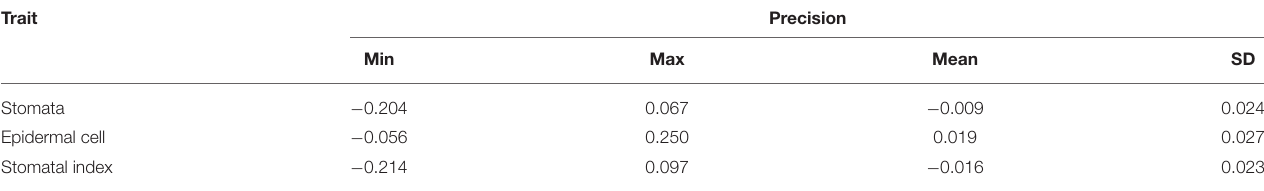
TABLE 2 | The precisions of stomata and epidermal cell counting and stomatal index measurement in 1,000 microscopical images of the wheat dataset. Trait Precision Min Max Mean